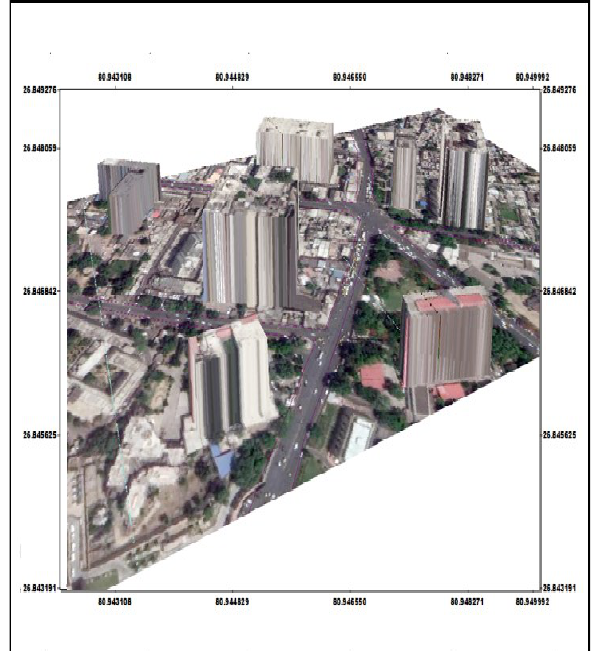
Figure 10. 3D view of Hazartganj intersection where the algorithmic model is been used to get the elevation and thereafter the noise values is been calculated over different buildings around the crossing.